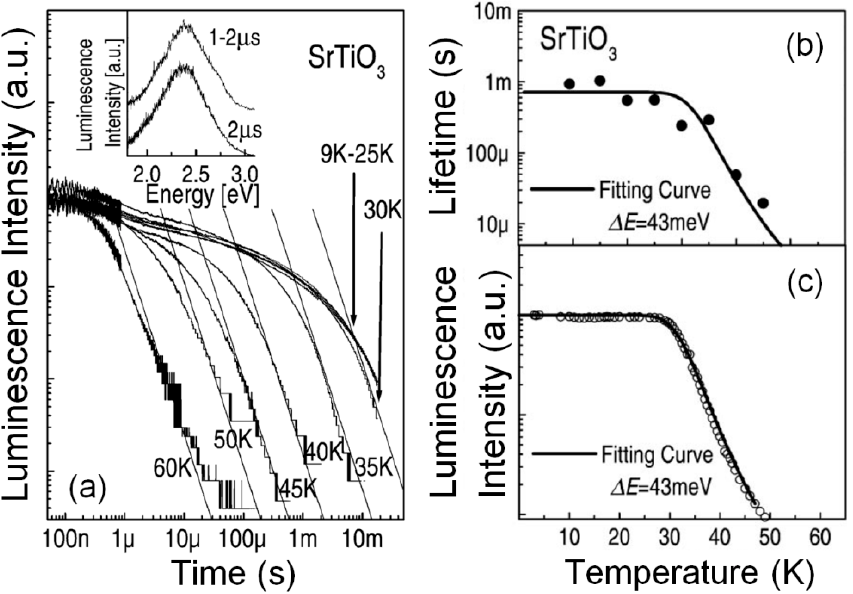
Figure 6. ( a ) PL decay curves detected at 500 nm (2.48 eV) versus temperature. Solid lines representing t − 2 dependence are drawn. Time resolved PL spectra observed at 4.5 K are shown as inset, ( b ) Temperature dependence of weighted mean lifetimes < τ > deduced from Equation (4) in [22], ( c ) Temperature dependence of the integrated PL intensity. Solid line represents fitting curve according to Equation (5) in [22] with activation energy ∆ E = 43 meV. (a.u. stands for “arbitrary units”). The figures in this composition have been reprinted from Hasegawa et al. [22], Copyright (2000), with permission from Elsevier.